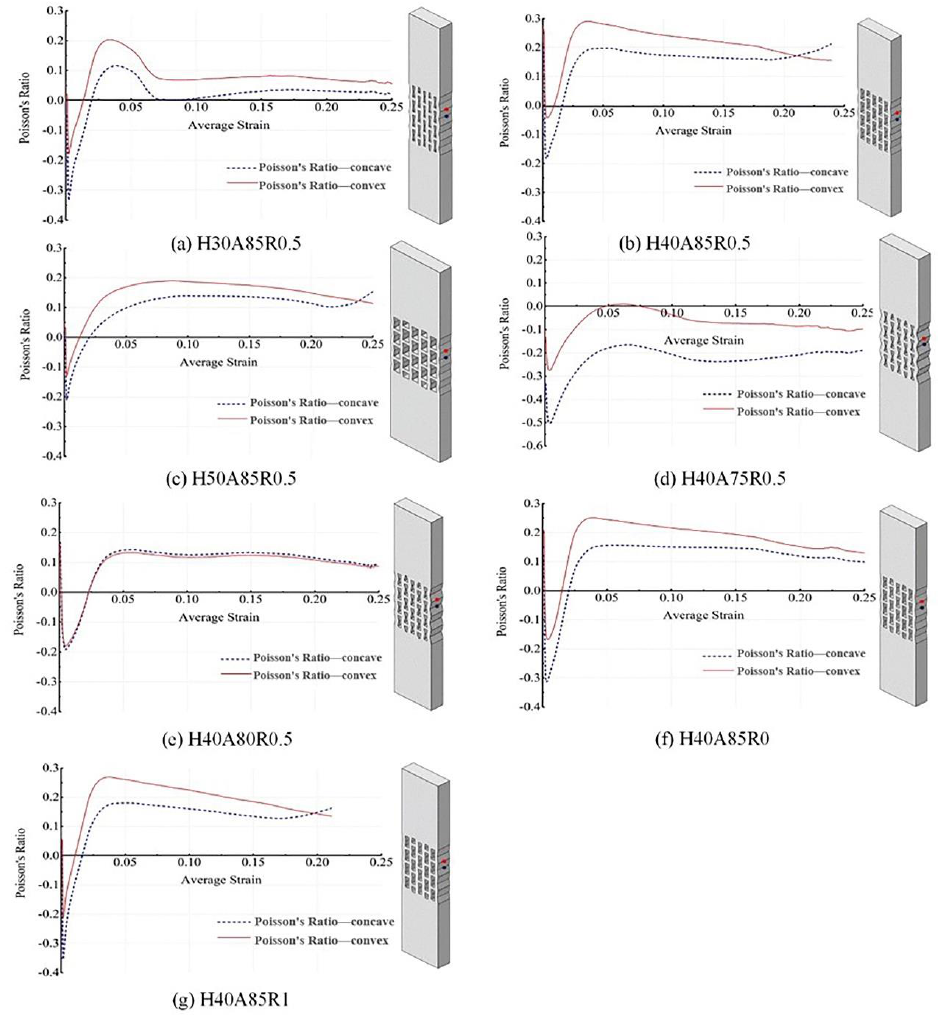
Figure 13. Effect of design parameters on Poisson’s ratio. Figure 13. E ff ect of design parameters on Poisson’s